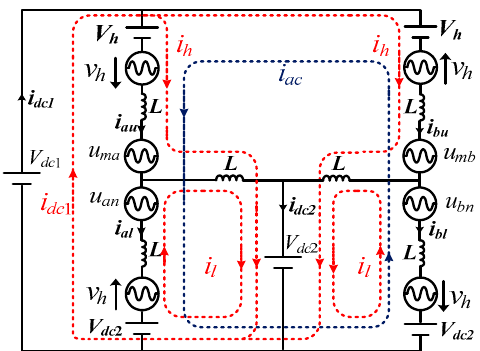
Figure 3. The equivalent model of the proposed DC-DC MMC.